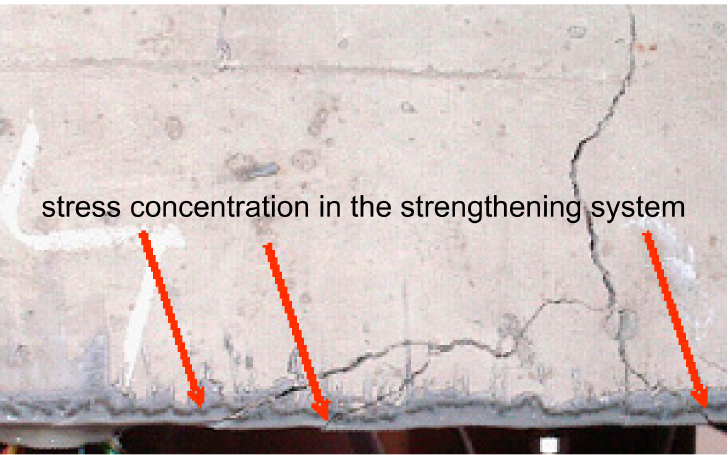
Figure 6. Local damages in a beam strengthened with carbon fibre reinforced polymer (CFRP) laminate bonded on epoxy resin adhesive generating high-stress concentrations in the strengthening system